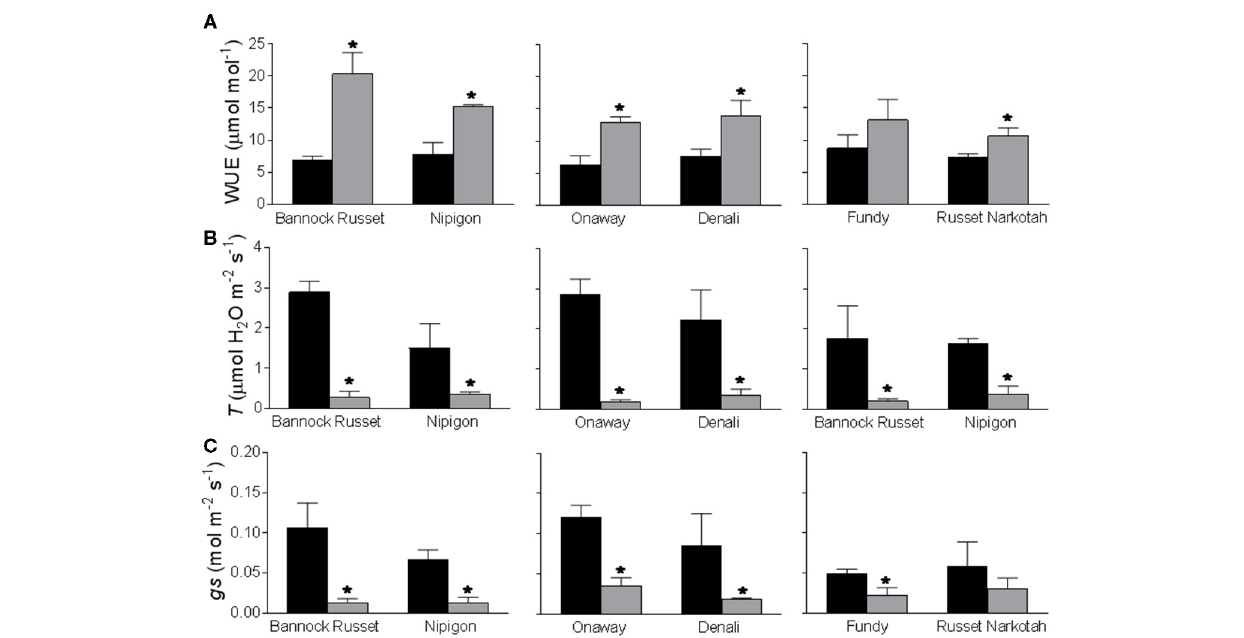
FIGURE 3 | Effects of drought stress on instantaneous water use efficiency (A) , transpiration rates (B) , and stomatal conductance (C) of six potato genotypes. The measurements were performed on the fully expanded terminal leaflets of 5-week-old well-watered plants or drought-stressed plants (analyzed after 6 days of withholding watering). The data represent the averages of three experiments ± SE. Significant differences of the means between well-watered and drought-stressed plants within each cultivar are indicated by the symbol * ( P ≤ 0.05).